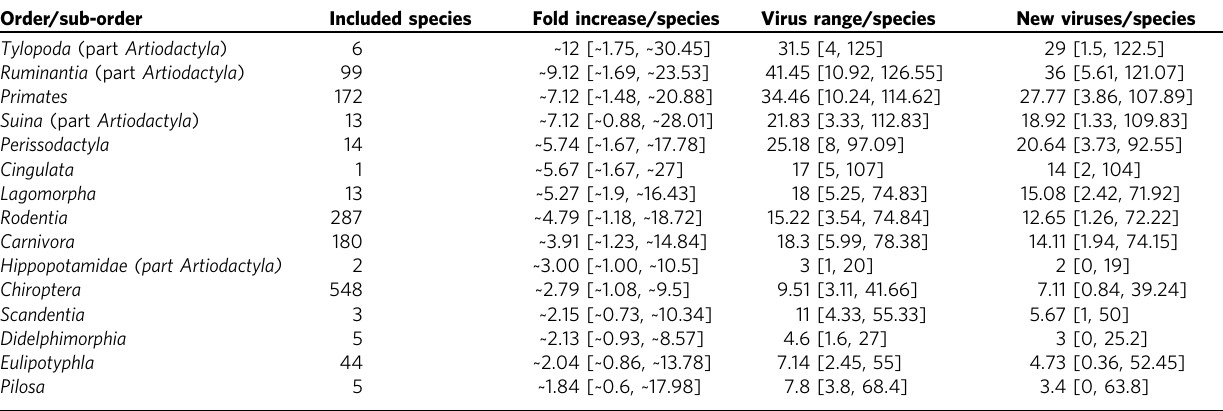
Table 4 Predicted number of viruses per top 15 orders by fold increase in number of viruses predicted in wild or semi- domesticated mammalian hosts (per